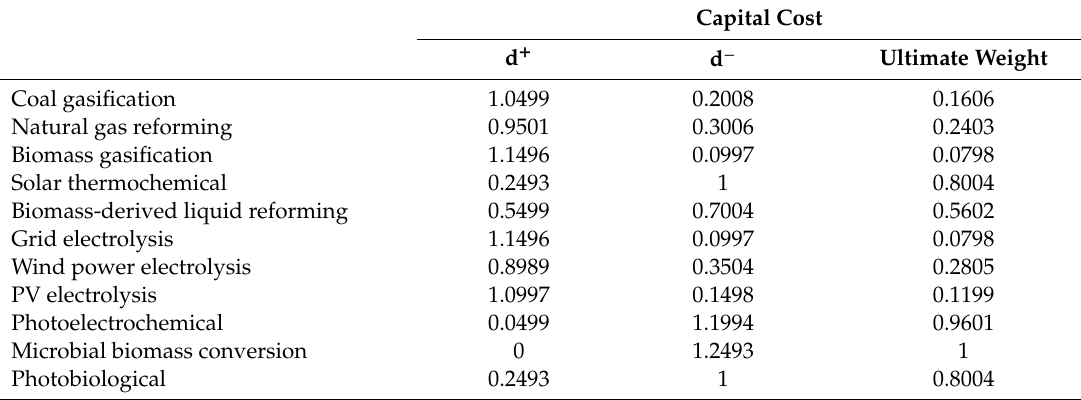
Table A1. Distance from fuzzy positive ideal solution (FPIS) and fuzzy negative ideal solution (FNIS), and ultimate weights of capital